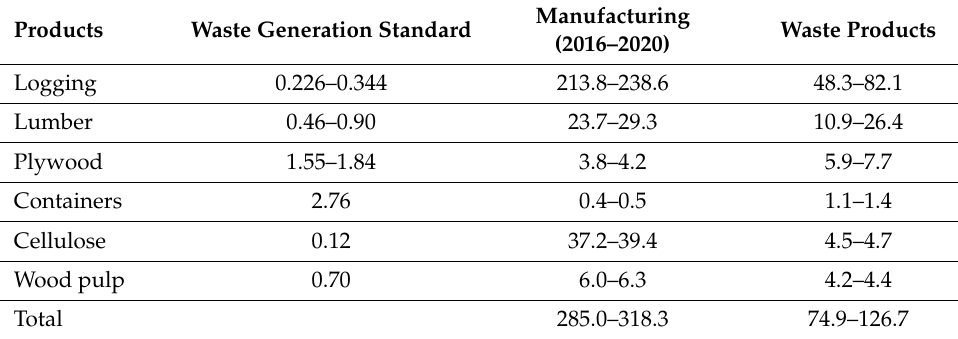
Table 3. Estimate of the volume of wood waste in Russia, million m 3